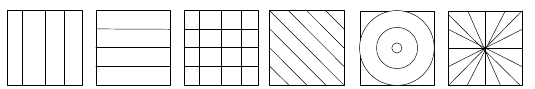
Figure 7. Type of Zoning (from left to right: vertical, horizontal, block, diagonal, circular, and radial zoning) [28].